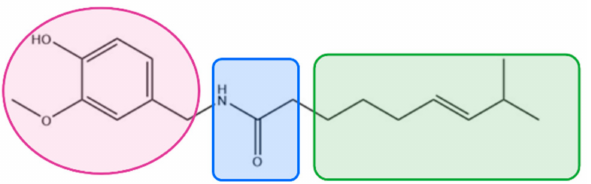
Figure 10. Chemical structure of capsaicin, a typical TRPV1 agonist (pink shape indicates vanillyl group, blue shape indicates amide group, green shape indicates aliphatic